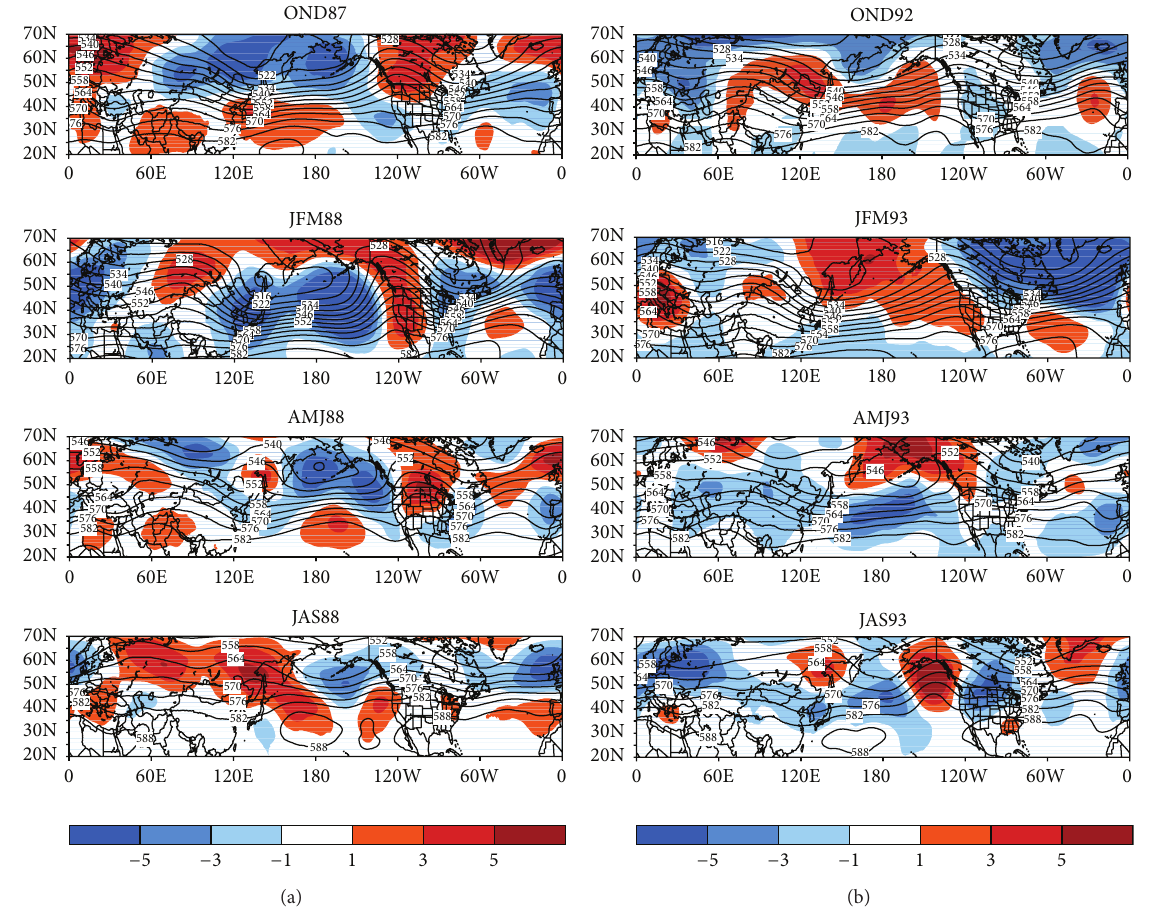
Figure 2: Seasonal 500 hPa heights and departures from normal (decameters) from CFSR data for (a) OND87 through JAS88 and (b) OND92 through JAS93. Seasonal normal taken relative to